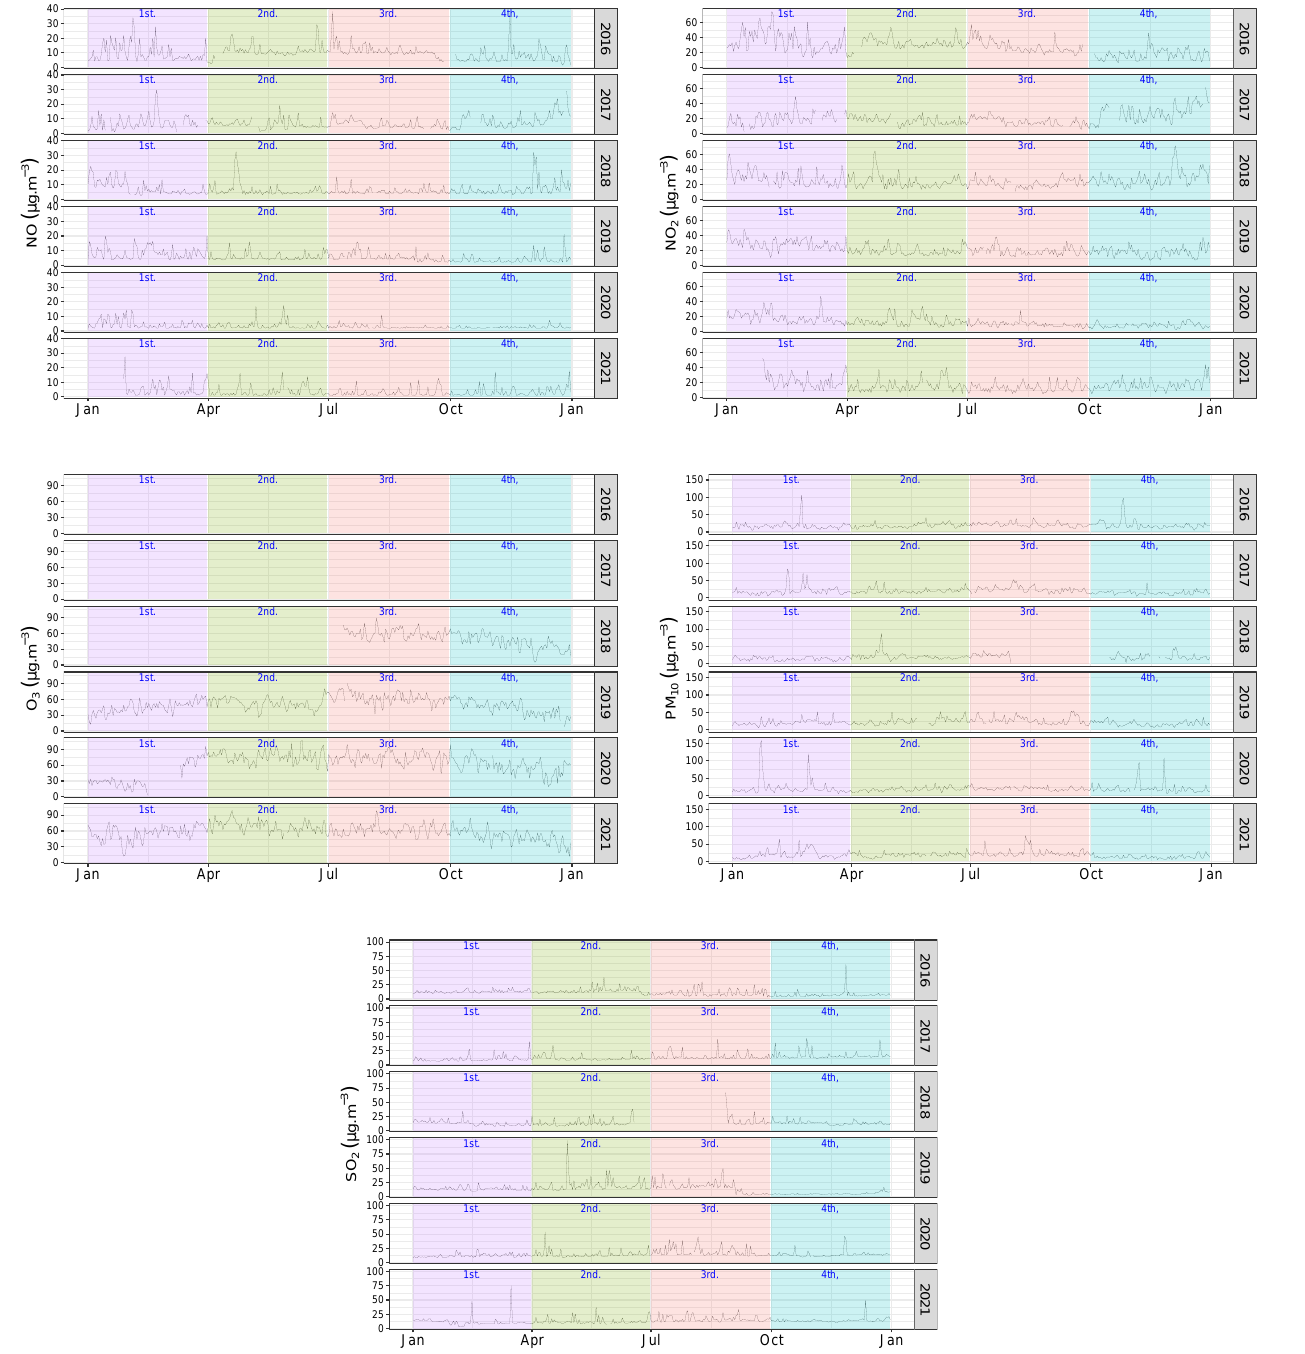
Figure 7. Evolution of the daily concentrations of NO, NO 2 , O 3 , PM 10 , and SO 2 at the Valle